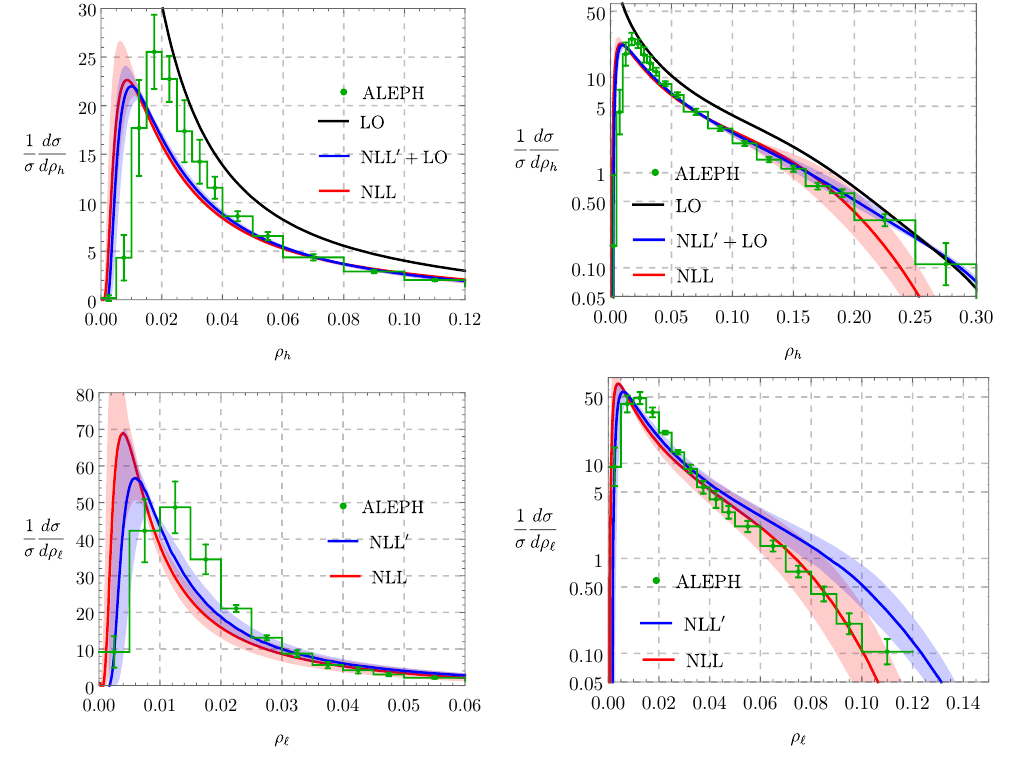
Figure 11 . Light-jet and heavy-jet mass distribution in comparison to ALEPH data